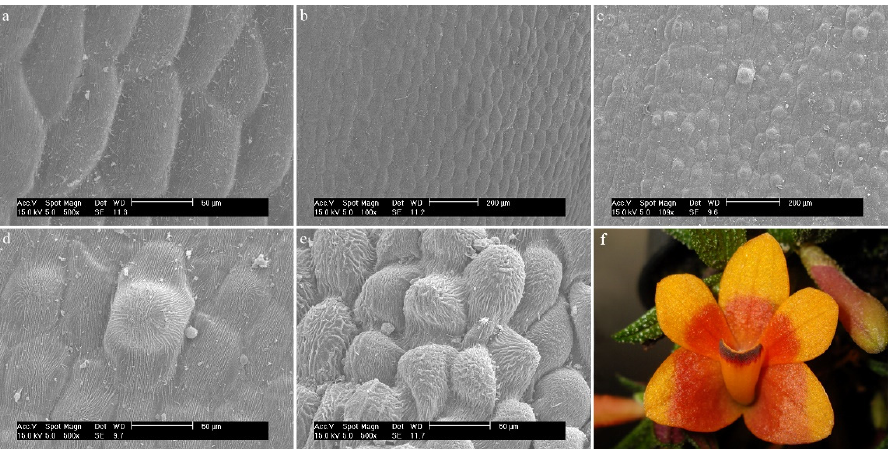
Figure 17. Dendrobium cuthbertsonii F.Muell.: ( a , b ) the hypochile part of the labellum; Papillae ( c , d ) of the mesochile part of the labellum; ( e ) of the epichile part of the labellum; ( f ) flower (photo by John Varigos).